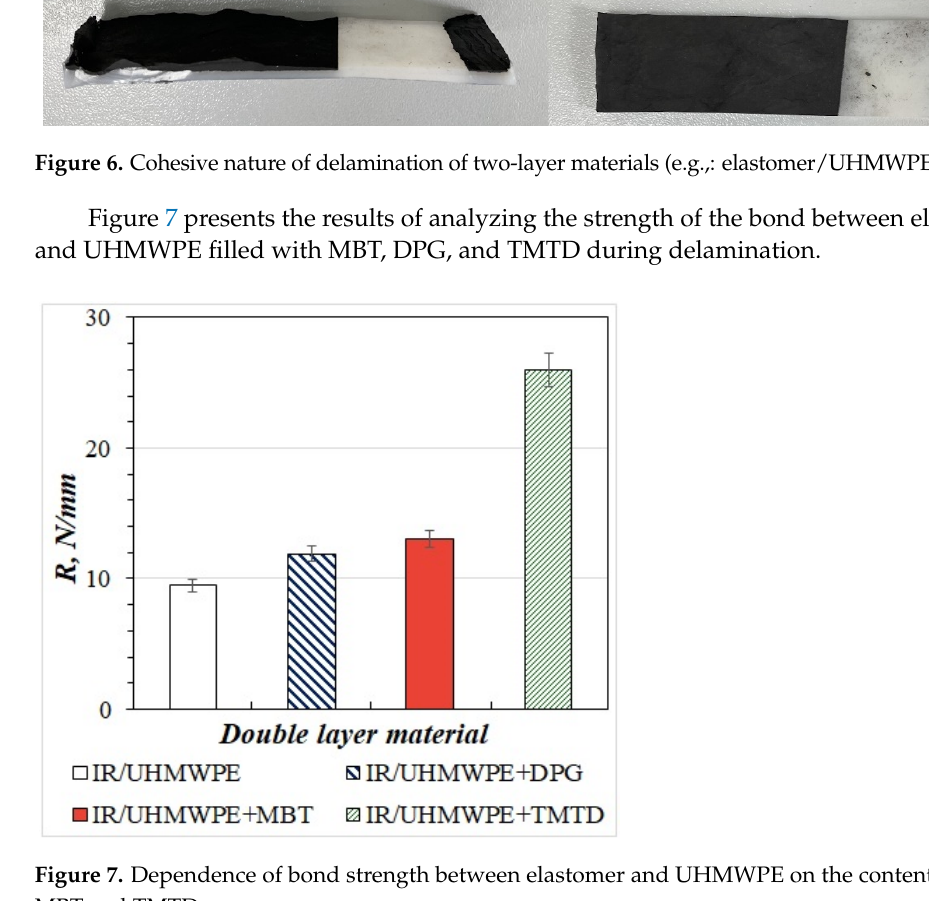
Figure 7. Dependence of bond strength between elastomer and UHMWPE on the content of DPG, MBT and TMTD.